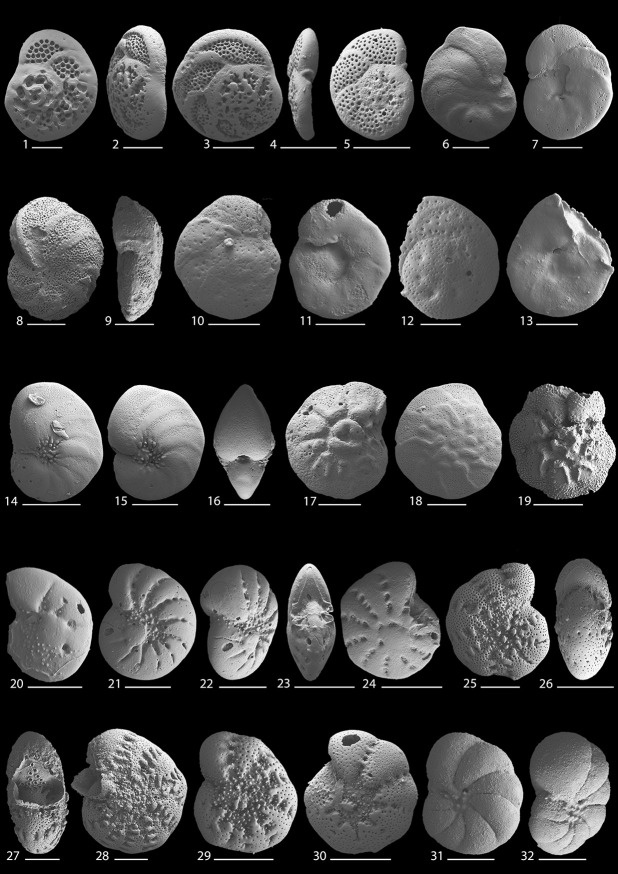
Scanning electron micrographs of benthic foraminifera from the Lagos Lagoon: 1–5.Rosalina cf. R. orientalis (Cushman, 1925); 6–9. Hanzawaia cf. H. nipponica Asano, 1944; 10–13. Planulina sp. 1; 14–16. Nonion fabum (Fichtel and Moll, 1798); 17–19. Pararotalia sarmientoi (Redmond, 1953); 20–24. Elphidium sp. 1; 25–30. Cribroelphidium mirum Langer and Schmidt-Sinns, 2006; 31, 32. Porosononion sp. 1. Scale bar is 100 μm for all magnifications and 50 μm for Figs 12.10–12.13, 12.31 and 12.32.